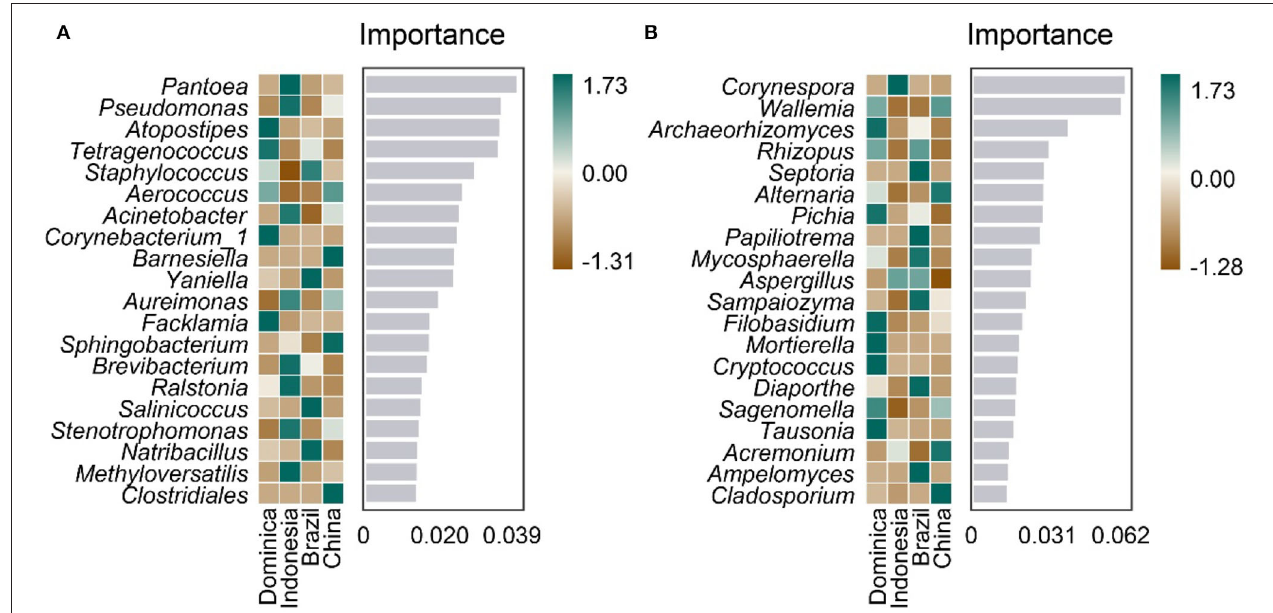
FIGURE 5 | Top 20 identity genus of bacterial (A) and fungal (B) communities used for discriminating tobacco leaves from different regions.